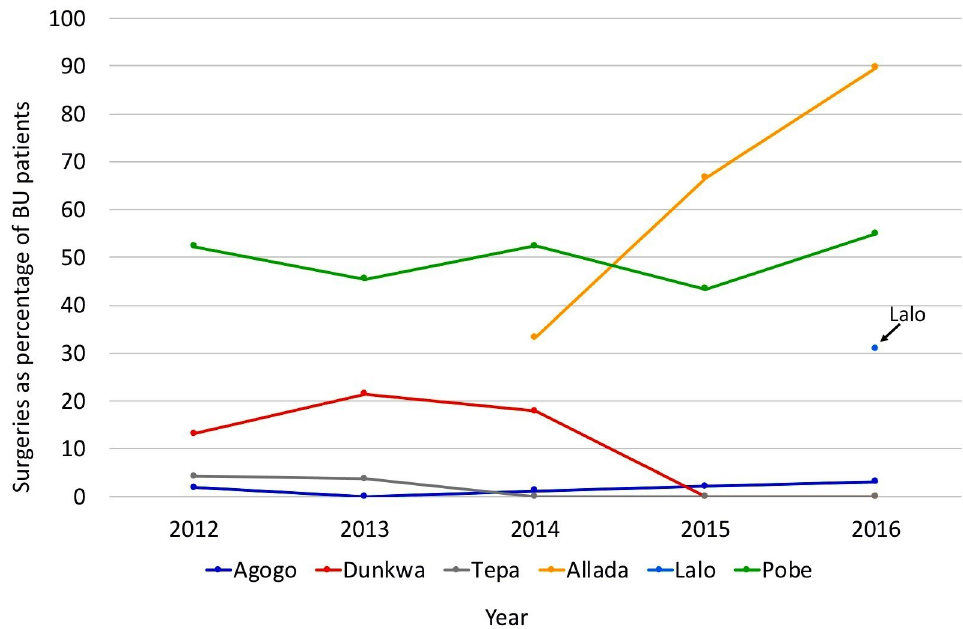
Fig 1. Surgical practices per center over the year. Data on surgery from Allada and Lalo not included for 2012/2013 and 2012–2015, respectively, due to clinical trial at these sites. In Allada linear by linear p < 0.001.